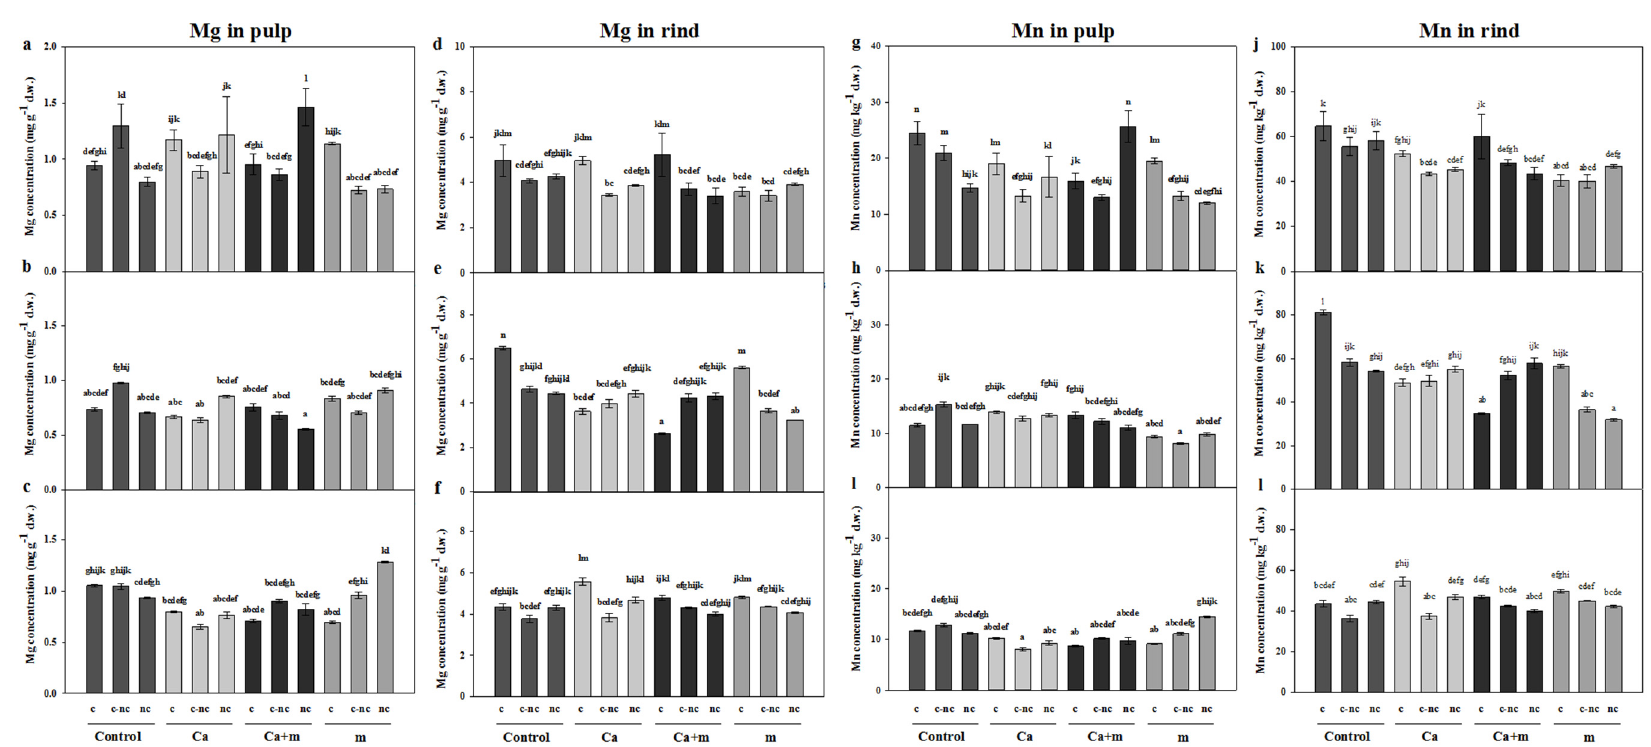
Figure 5. Mg concentration (dry weight basis) in pulp, ( a ) control irrigation, ( b ) conductivity irrigation, and ( c ) double irrigation, and rind, ( d ) control irrigation, ( e ) conductivity irrigation, and ( f ) double irrigation. Mn concentration (dry weight basis) in pulp, ( g ) control irrigation, ( h ) conductivity irrigation, and ( i ) double irrigation, and rind, ( j ) control irrigation, ( k ) conductivity irrigation, and ( l ) double irrigation. The Ca treatment consisted of 8 mM CaCl 2 and 2 mM CaSO 4 , the Ca + m treatment consisted of a commercial mixture (Antisal gold, Nufol ® ) and the m treatment consisted of another commercial mixture (Microfold, Nufol ® ). Codes: c, cracked region in cracked fruit. c-nc, non-cracked region in cracked fruit. nc, non-cracked fruit. Statistical analysis was performed using SPSS 25.0.0.1. and included all the irrigation treatments, separating each element and each type of tissue. The values are the means ± Standard Error of three individual analyses. Columns with different letters differ significantly according to Duncan’s test ( p = 0.05).